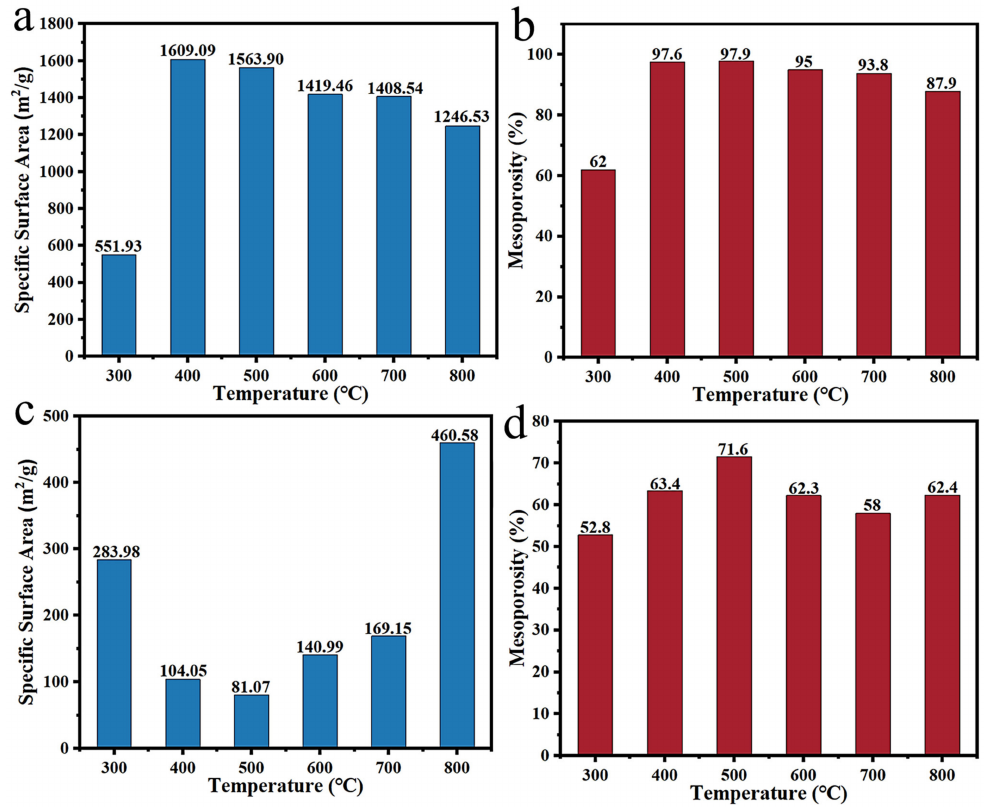
Figure 11. The impacts of one-step activation temperature on specific surface area ( a ) and meso- porosity ( b ); The impacts of two-step activation temperature on specific surface area ( c ) and mesoporosity ( d )